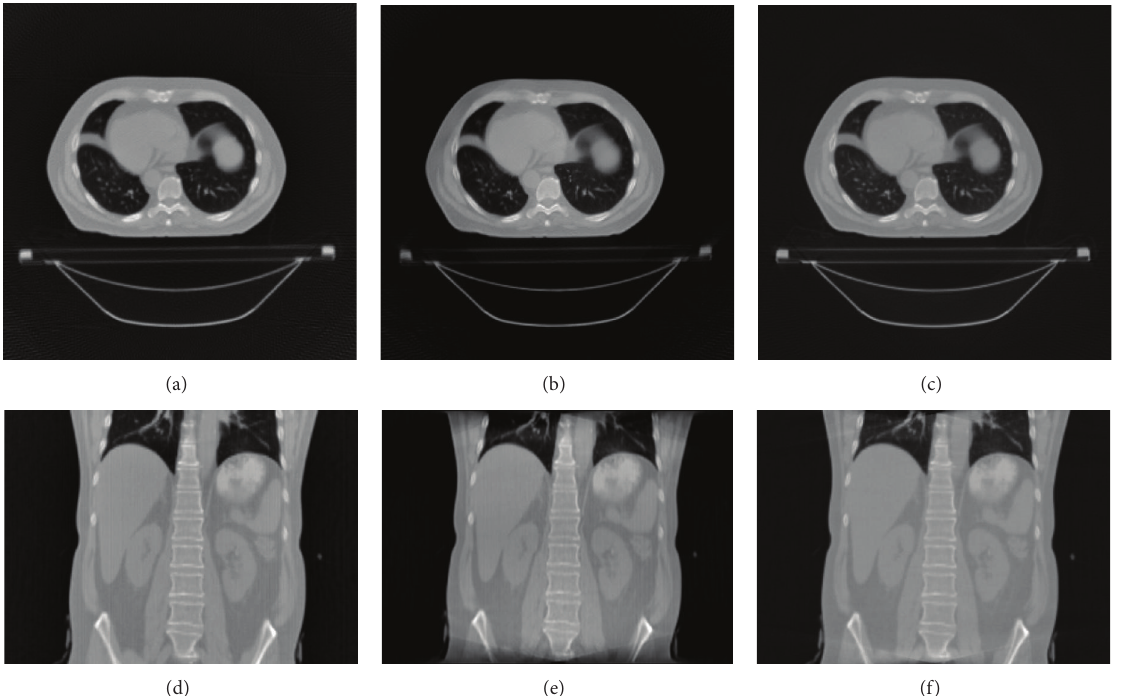
Figure 10: Reconstructed (top row) transverse images of a patient using the (a) fan-beam, (b) FDK, and (c) SART algorithms. Reconstructed (bottom row) coronal images using the (d) fan-beam, (e) FDK, and (f) SART algorithms.